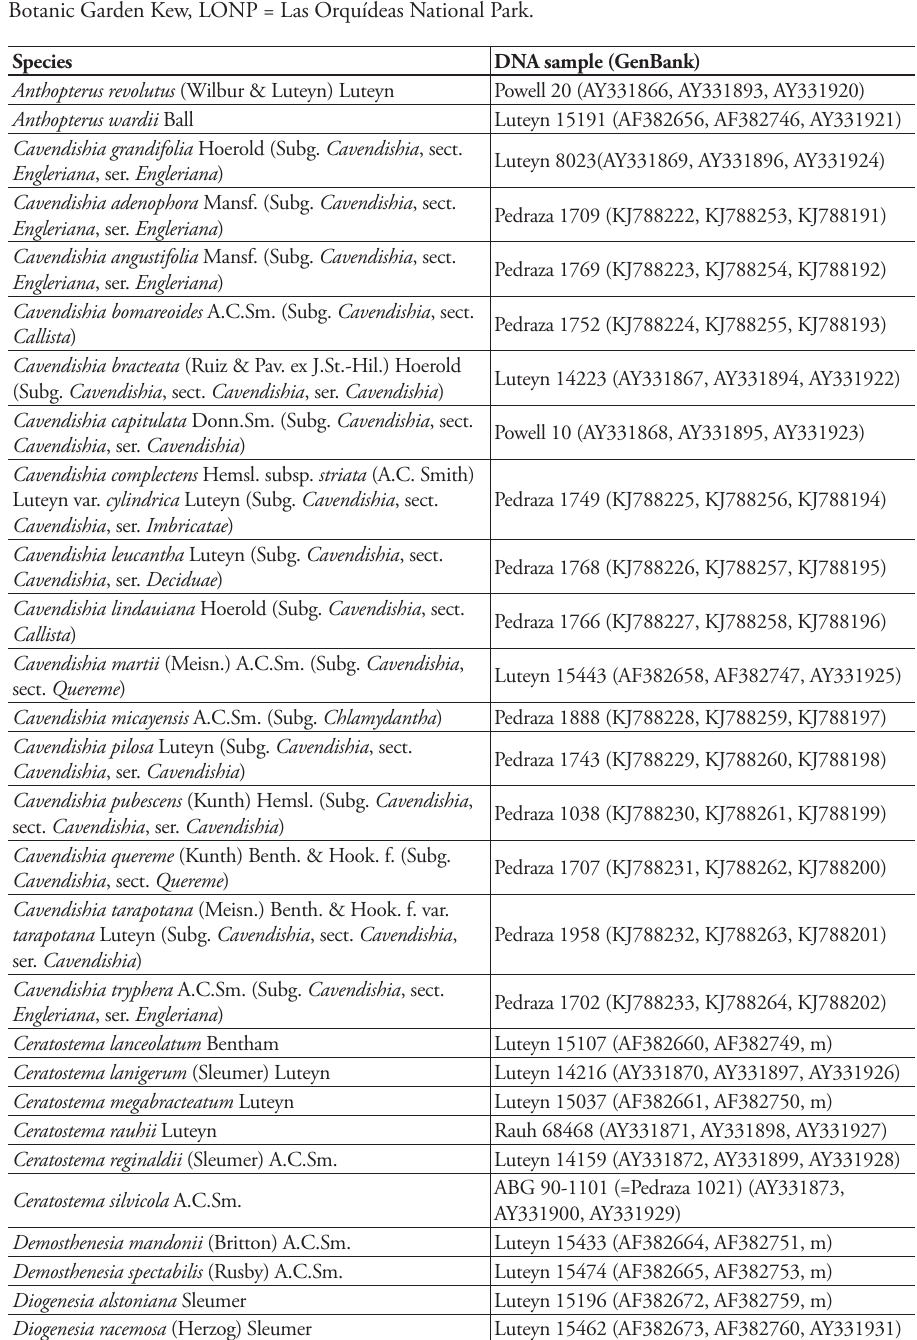
Table 1. Species of Vaccinieae studied with their corresponding voucher specimens and GenBank acces- sion numbers (ITS, matK , ndhF ). m = missing, RBGE = Royal Botanic Garden Edinburgh, RBGK = Royal Botanic Garden Kew, LONP = Las Orquídeas National